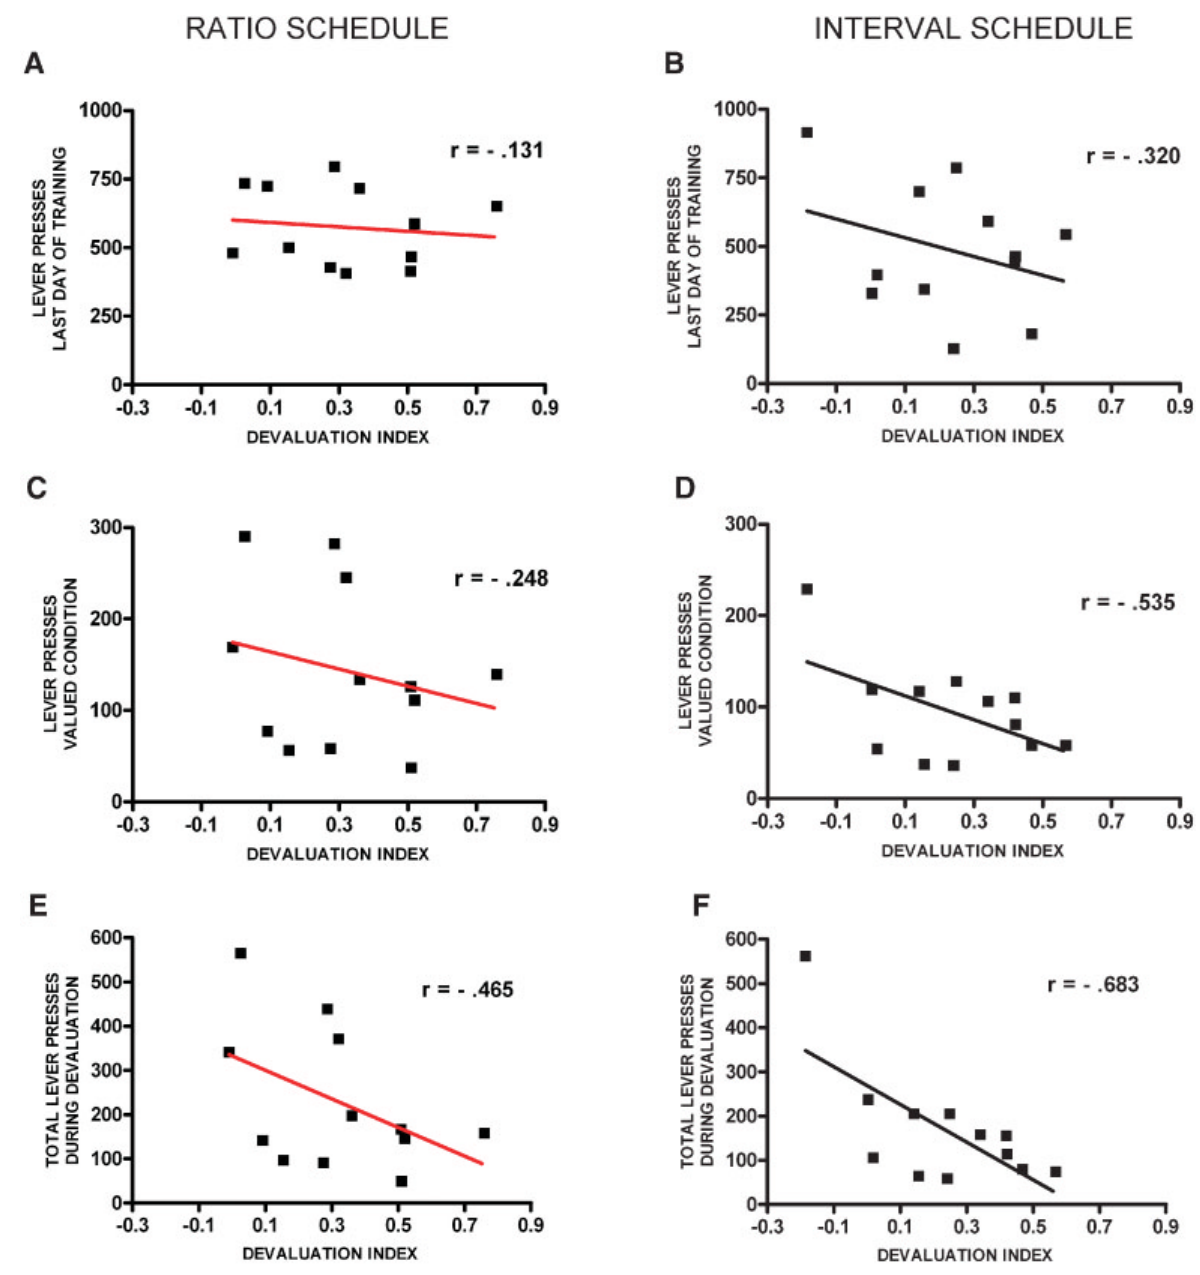
Figure2. Correlation between the levels of lever pressing and devaluation for random ratio and random interval trained animals . ( A ) Correlation between the total number of lever presses during the last day of training and the devaluation index in animals trained on random ratio. ( B ) Correlation between the total number of lever presses during the last day of training and the devaluation index in animals trained on random interval. ( C ) Correlation between the total number of lever presses during the valued condition and the devaluation index in animals trained on random ratio. ( D ) Correlation between the total number of lever presses during the valued condition and the devaluation index in animals trained on random interval. ( E ) Correlation between the total number of lever presses during both days of the devaluation test and the devaluation index in animals trained on random ratio. ( F ) Correlation between the total number of lever presses during both days of the devaluation test and the devaluation index in animals trained on random interval.